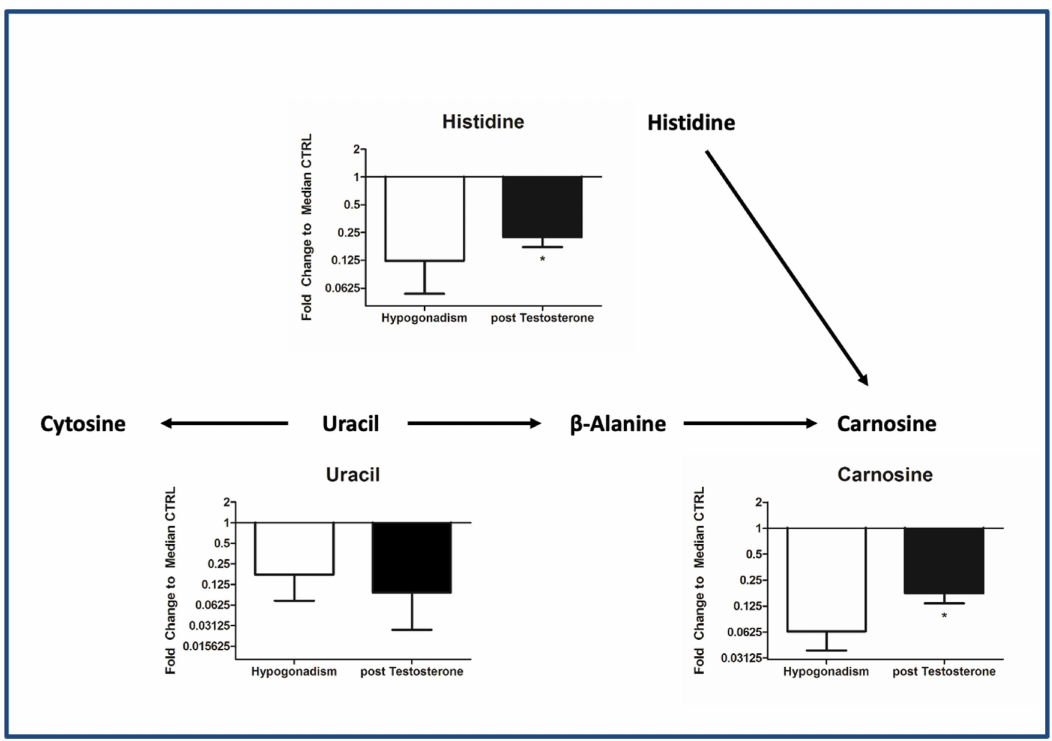
Figure 6. Metabolism of the production of carnosine from β -alanine. All data are shown as mean ± SEM of fold-change relative to the metabolite levels in controls. * p <